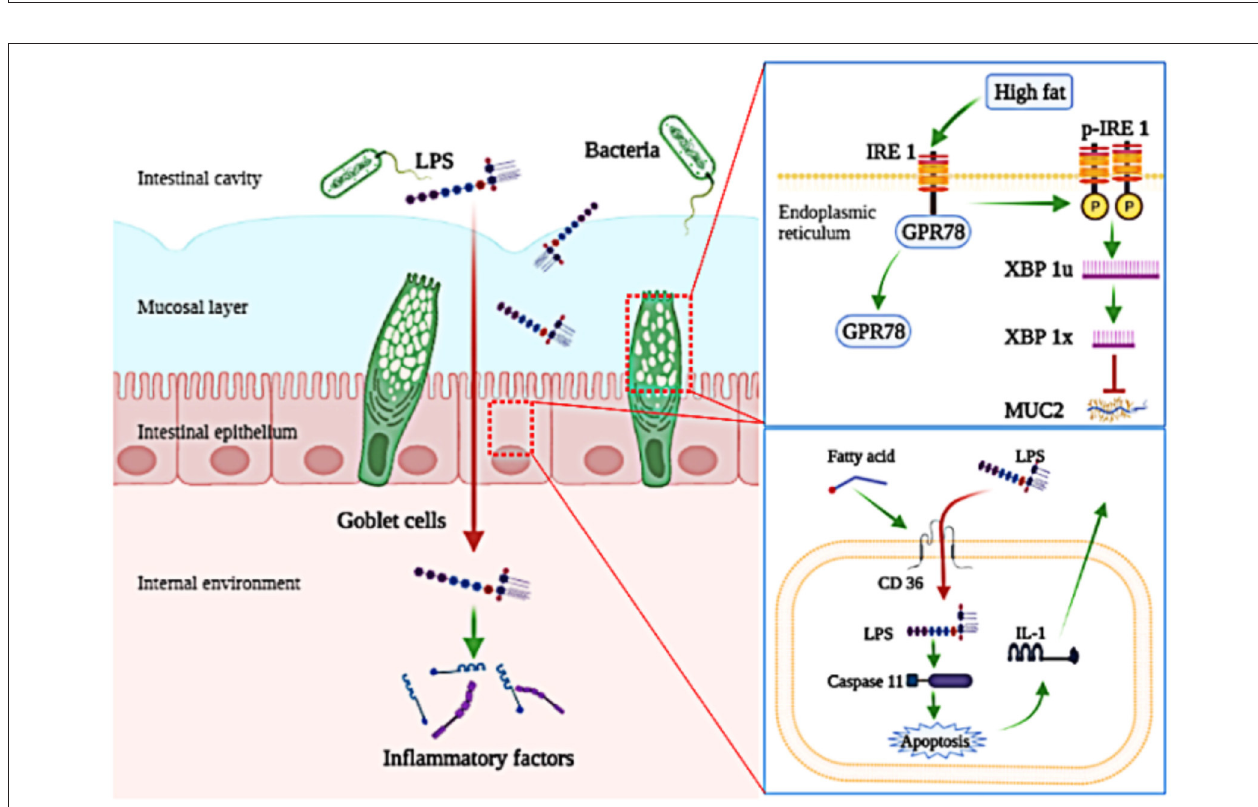
FIGURE 7 | A schematic diagram shows key molecular pathways involved in the penetration of LPS induced by high-fat diet. Consumption of high-fat diets increases the penetration of LPS, which induces low-grade chronic inflammation; Consumption of high-fat diets inhibit the secretion of MUC2 by activating the IRE1/XPB-1 signaling pathway in goblet cells; Fatty acids assist in the cellular internalization of LPS and then activate its intracellular signaling pathway depending on CD36 in intestinal epithelial cells.